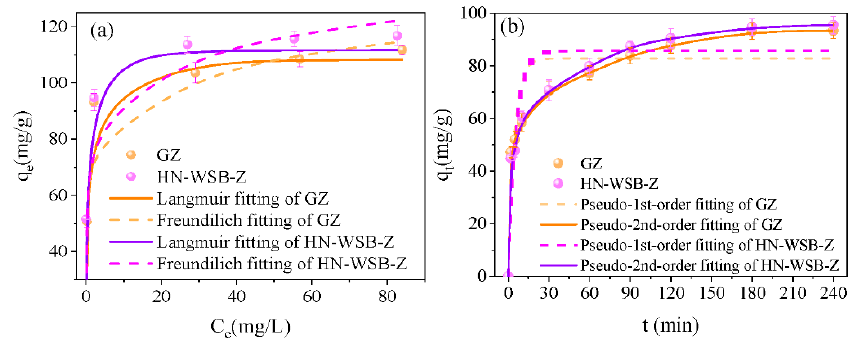
Figure 6. Cu(II) adsorption isotherm fitting curves of GZ and HN-WSB-Z ( a ); nonlinear fitting of pseudo-1st-order and pseudo-2nd-order for Cu(II) adsorption by GZ and HN-WSB-Z ( b ). (Conditions: T = 298 K, t = 180 min, C 0 = 20 mg/L, dosage = 0.2 g/L).